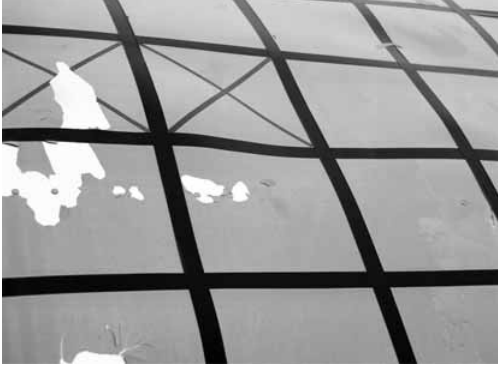
Fig. 36. Outer skin plastic deformation after basic shield